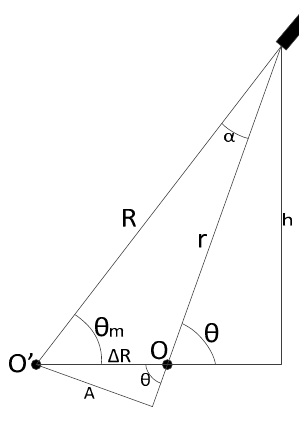
Figure 4. Optical encoder with eccentricity bias. Sensors 2017 , 17 , 2171